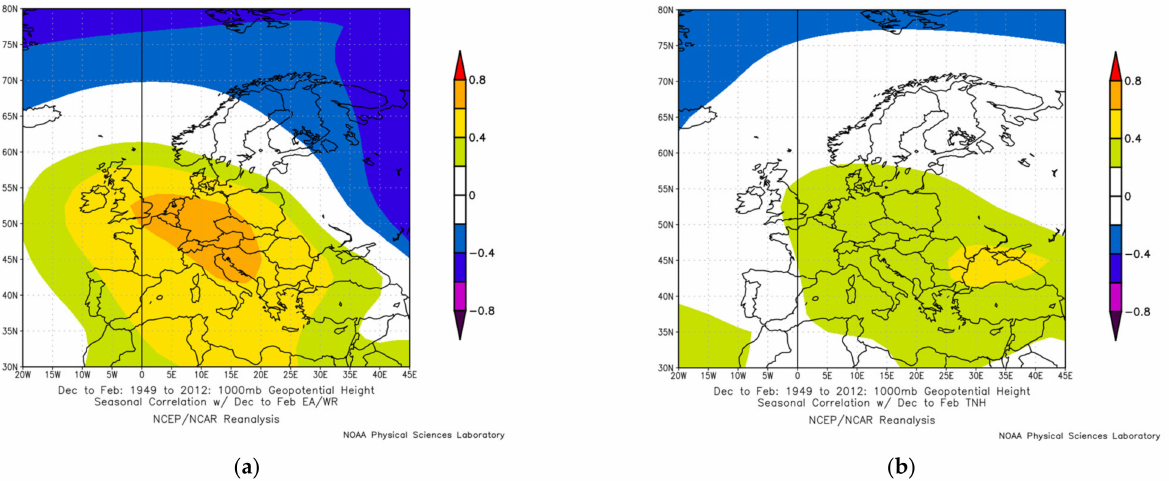
Figure 10. Winter correlations of the 1000 hPa geopotential height with the ( a ) EA/WR and ( b ) TNH indices. Correlation coefficients r < − 0.2 and r > + 0.2 are significant at the 90% confidence